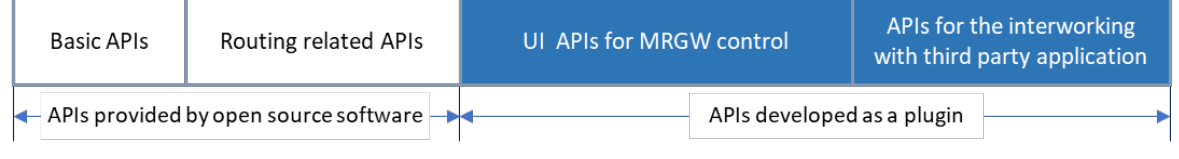
Figure 3. API structure for MRGW access and control.